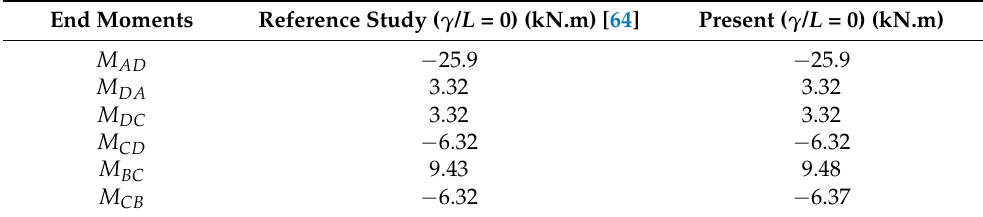
Table 3. End moments for a frame system subjected to horizontal triangular load [64].